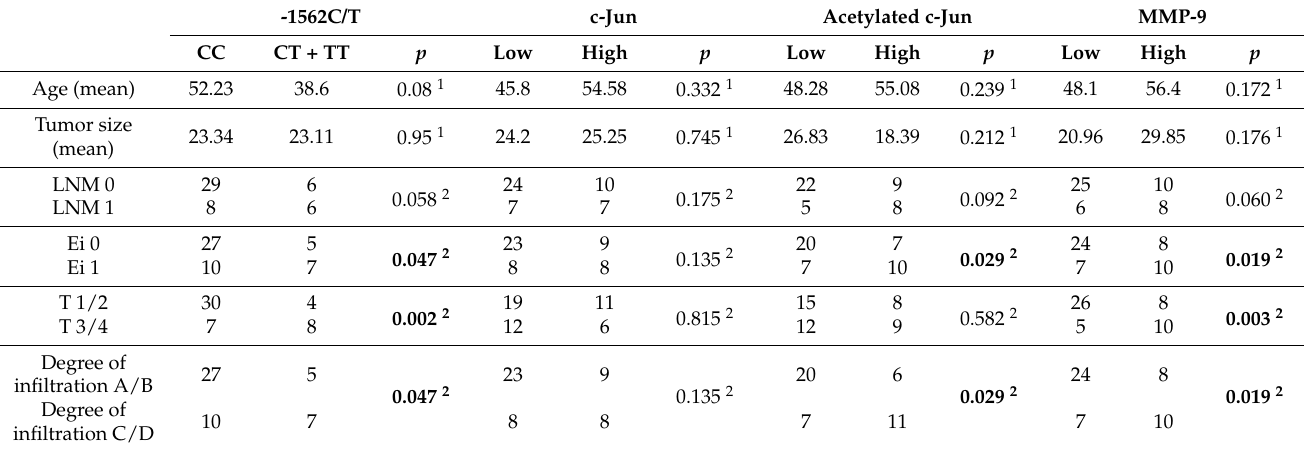
Table 1. Association of -1562 C/T polymorphism, c-Jun, acetylated c-Jun, and MMP-9 protein levels with selected clinicopathological parameters of PTC.